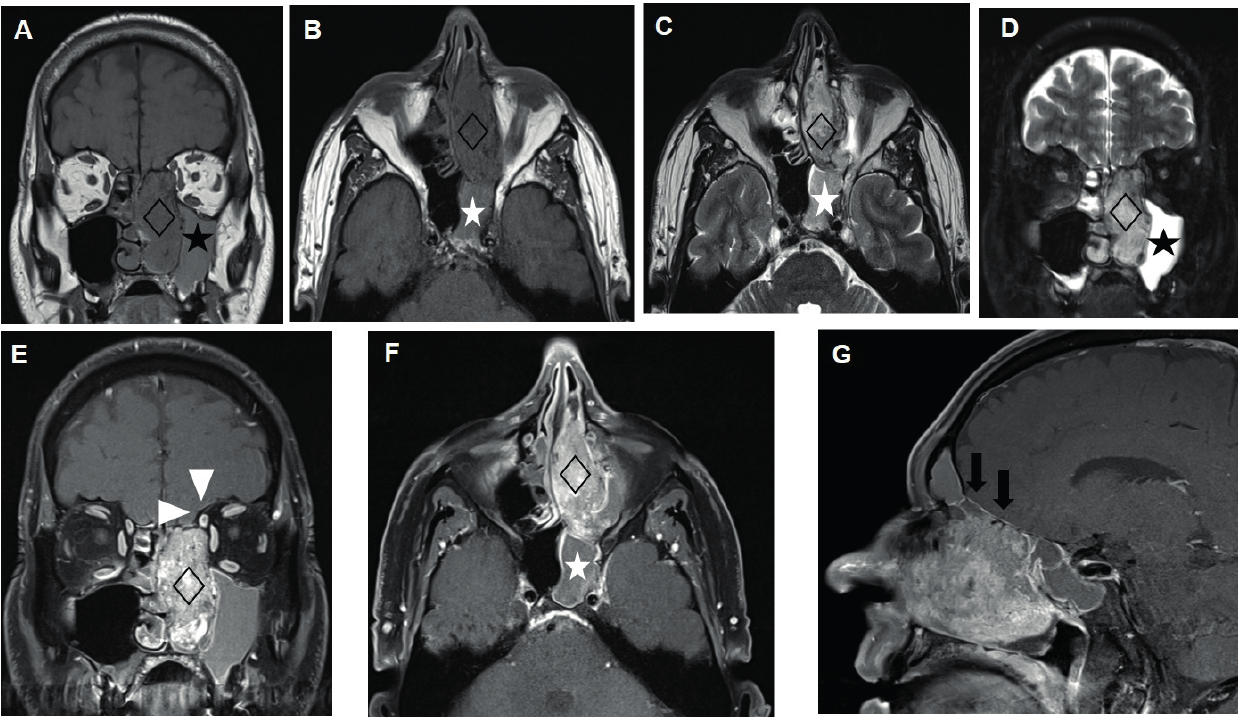
Figure 1. Magnetic resonance imaging for initial staging of a 55-year old male patient with a biopsy-proven sinonasal undifferentiated carcinoma (SNUC). On T1-weighted, non-enhanced coronar (A) and transverse (B) sections, we see a heterogeneous, mostly hypointense, obstructing and poorly demarcated tumour in the nasal cavity and in the adjacent ethmoidal cells (black rhomb), with secondary opacification of the MS (black asterix) and the SS (white asterix) due to mucus retention. On T2-weighted, non-enhanced transverse sections (C), the tumour (black rhomb) displays an inhomo- geneous, intermediate signal (white asterix, SS). On T2-weighted, FS coronar images (D), the tumour (black rhomb) is easy to differentiate from mucus retention in the MS (black asterix). As best seen on T1-weighted, CE FS coronar (E) sections in combination with T1-weighted non-enhanced coronar sections (A), a clear distinction between erosion and infiltration of the bony orbit and periorbita in its supero-medial quadrant in proximity to supe- rior oblique muscle is challenging (white arrowheads, (E)). However, no affection of the extraconcal adipose tissue or extraocular eye muscles was suspected. On T1-weighted CE FS axial (F) sections, we can confirm an inhomogeneous tumour (black rhomb) in the nasal cavity and ethmoidal cells, with secondary opacification of the SS (white asterix). On T1-weighted CE FS sagittal sections (G), we see a linear and thin dural enhancement (black arrows), which is most likely reactive. Intraoperative exploration of the tumour revealed an infiltration of the periorbita in its supero-medial quadrant, without affection of the extraconal fat tissue or the extraconcal eye muscles. However, no evidence of infiltration of the bony or dural skull base was found. CE, contrast-enhanced; FS, fat-suppressed; MS, maxillary sinus; SS, sphenoid